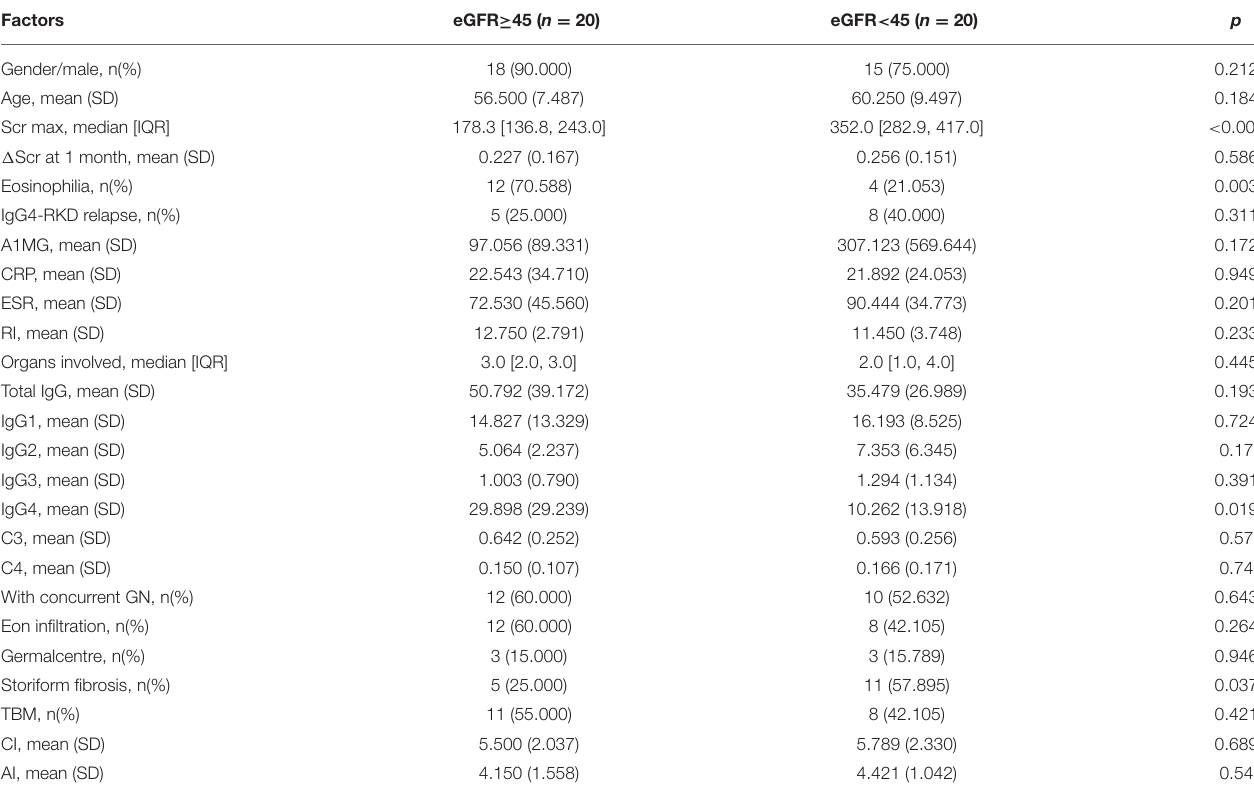
TABLE 4 | The comparison between patients with good or poor long-term prognosis. Factors